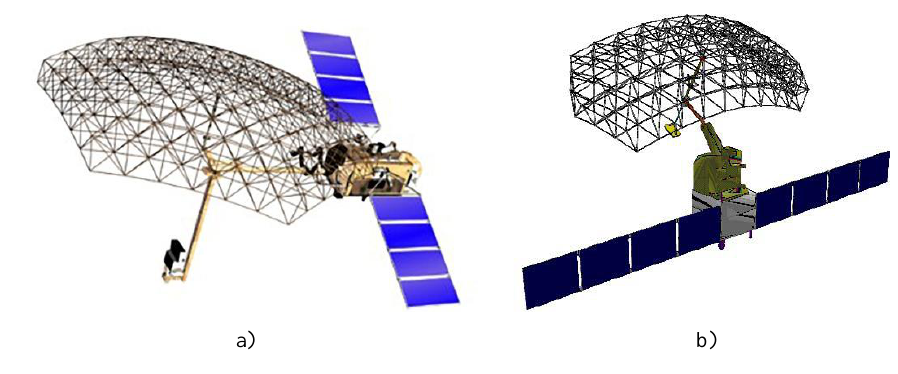
Fig. 4. Space satellites with truss reflectors.